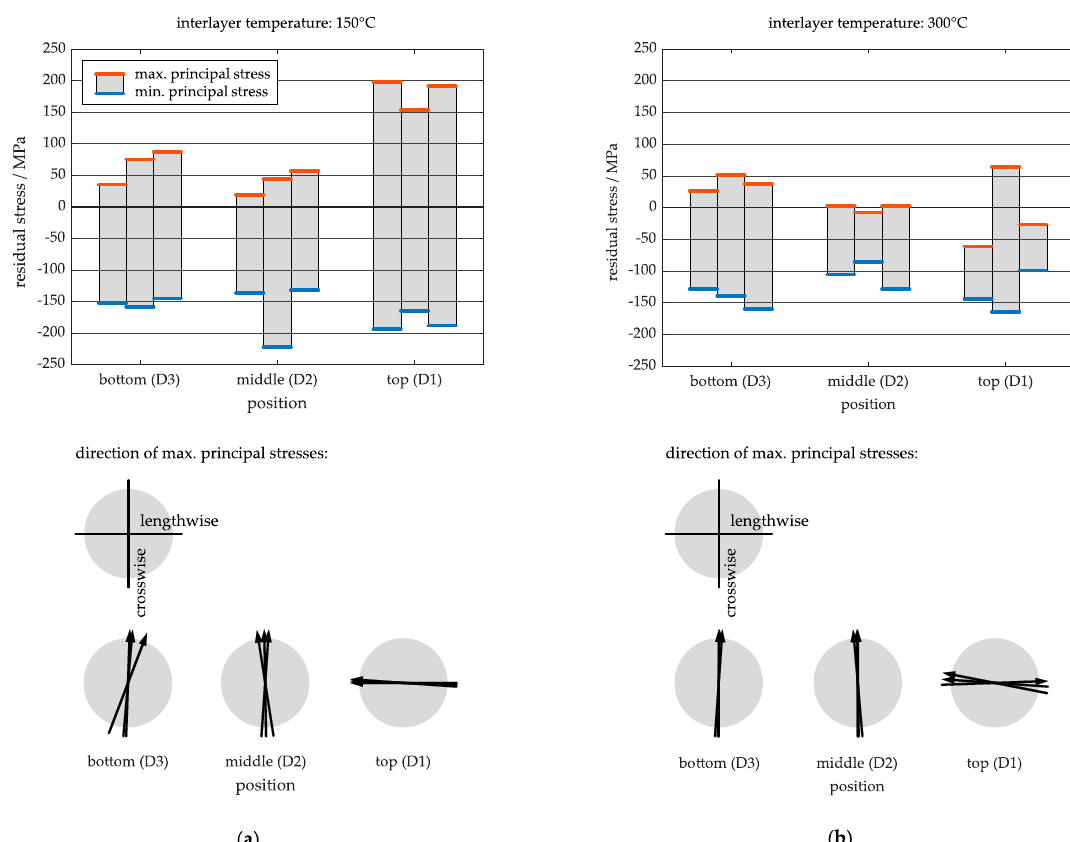
Figure 6. Residual stresses (principal stresses) and corresponding directions for the maximum prin- ciple stresses determined using the hole-drilling method for interlayer temperatures of 150 °C ( a ) and 300 °C ( b